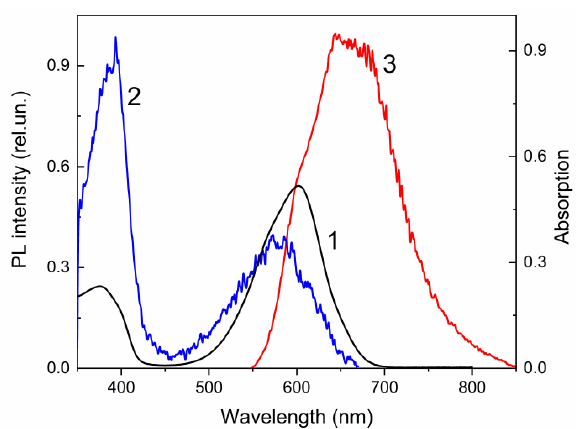
Figure 6. The absorption (1), PL excitation (2) and PL (3) spectra of compound 22 in THF solution. λ em = 680 nm (2), λ exc = 530 nm (3). T = 298